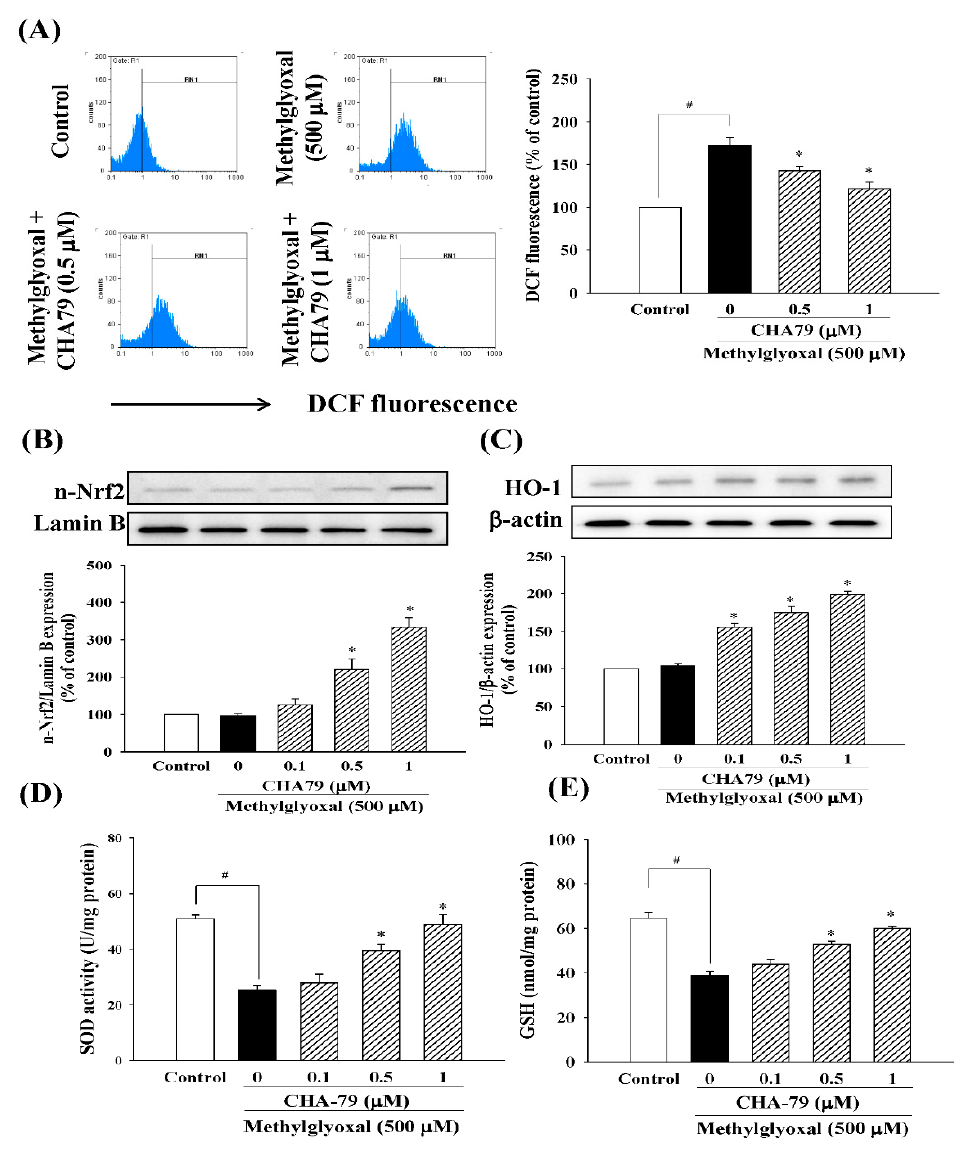
Figure 6. CHA79 down-regulated ROS production ( A ), up-regulated nuclear-Nrf2 (n-Nrf2) expression ( B ), HO-1 expression ( C ), SOD activity ( D ), total GSH level ( E ) in MG-treated SH-SY5Y dopaminergic neurons. One-hour pre-treatment with CHA79 (0.1–1 μ M) followed by 24 h MG (500 μ M) exposure was carried out. Fluorescent DCF was measured a by flow cytometer as the indicator of ROS production. WB data are presented as % of control follow by normalization with internal standard ( β -actin or Lamin B). Commercial kits were used for detecting GSH and SOD. Data are shown as mean ± SEM ( n = 6). # p < 0.05 versus the control group (vehicle control: 0.1% DMSO). * p < 0.05 versus the MG